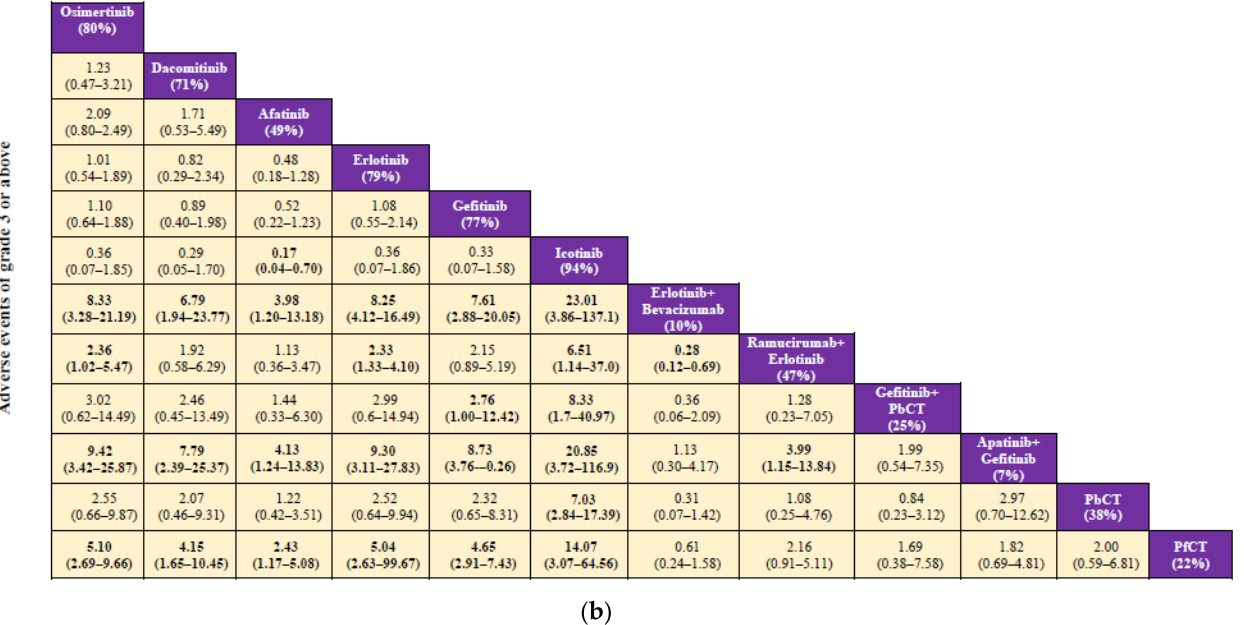
Figure 3. Pooled estimates for the network meta-analysis. ( a ) Pooled hazard ratios (95% confidence intervals) for overall survival (lower triangle) and progression-free survival (upper triangle). P scores for overall survival (left) and progression-free survival (right) are shown beneath the respective treatments. ( b ) Pooled odds ratios (95% confidence intervals) for grade ≥ 3 adverse events. P- scores are indicated below the respective treatments. The data in the cells represent hazard ratios or odds ratios (95% confidence intervals) comparing row-defining treatment versus column-defining treatment. If the value of the hazard ratio or odds ratio is less than 1, then the row-defining treatment is favored. Results considered significant are highlighted in bold. NA, not available; PbCT, pemetrexed-based chemotherapy; PfCT, pemetrexed-free chemotherapy.